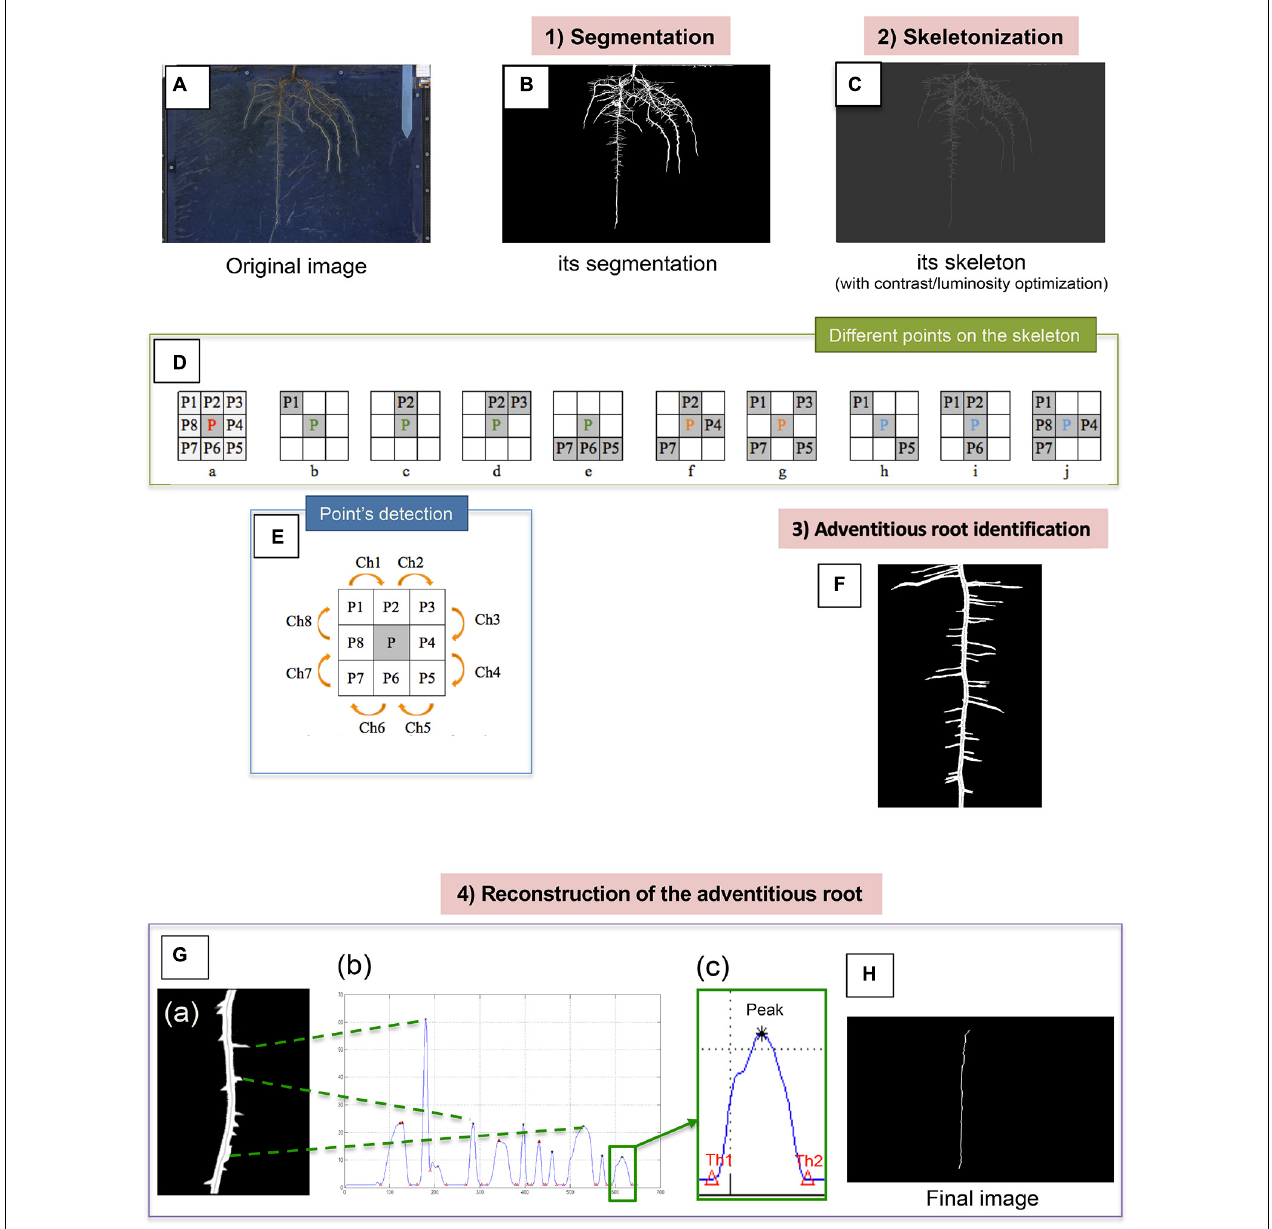
FIGURE 2 | Summary of the different steps allowing the detection of the adventitious roots from the images acquired from the rhizotrons. The original image (A) firstly undergoes segmentation, which allows us to obtain a binary image (B) . Root skeletonization (C) . For each pixel in a digital binary image, 8 neighborhoods of a pixel P are defined: 4 points in direct direction and 4 other ones in diagonal direction (D a ) . Different points on the skeleton can be distinguished: the endpoints (b–e), the junction points (f and g) and the normal points (h–j). Points detection (E) . Identification of the adventitious root (F) . Reconstruction of the adventitious root (G) . Example of image of the “pruned” root (a). Histogram of the vertical radius of the right part of the root (b) thresholds (Th1 = lower threshold, Th2 = upper threshold) around a peak (c). Final image of the adventitious root without lateral information (H)